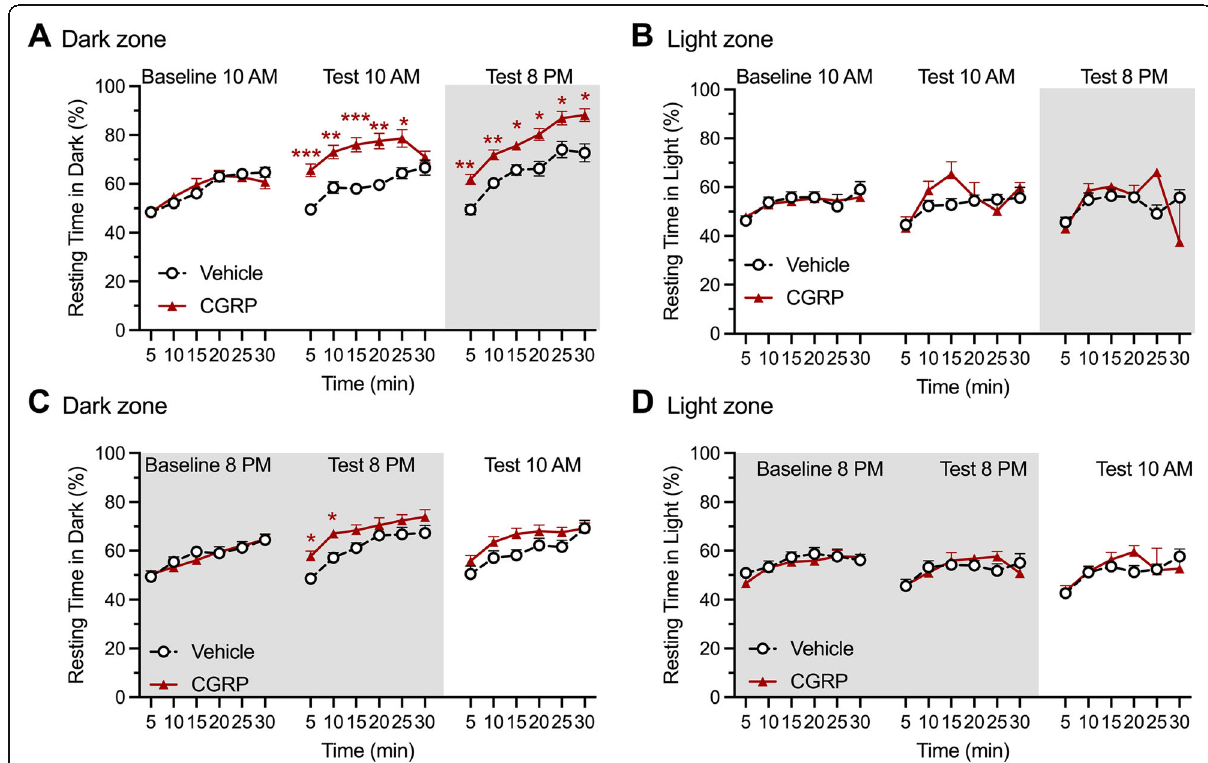
Fig. 5 Peripheral CGRP increases the time resting in the dark during both the active and inactive phases. In all panels, grey areas represent the active phase of the animals when lights of the facility were turned off (night). Percent time resting in the dark and light zones by CD1 mice during sequential exposures to the light/dark chamber at 25,000 lx (same experiments as in Fig. 2). On test days, animals were tested 30 min after injection of vehicle (PBS, i.p.) or CGRP (0.1 mg/kg i.p.). A Resting time in dark zone during the same experiment represented in Fig. 2A. Two-way (factors: time x treatment) ANOVA, Sidak ’ s multiple comparison test * p < 0.05, ** p < 0.01 and *** p < 0.001 compared to corresponding time point in vehicle group. B Resting time in light zone during the same experiment represented in Fig. 2A. Two-way (factors: time x treatment) ANOVA (treatment factor p = 0.2743 for first test and p = 0.8969 for second test). C Resting time in dark zone during the same experiment represented in Fig. 2C. Two-way (factors: time x treatment) ANOVA, Sidak ’ s multiple comparison test * p < 0.05, ** p < 0.01 and *** p < 0.001 compared to corresponding time point in vehicle group. D Resting time in light zone during the same experiment represented in Fig. 2C. Two-way (factors: time x treatment) ANOVA